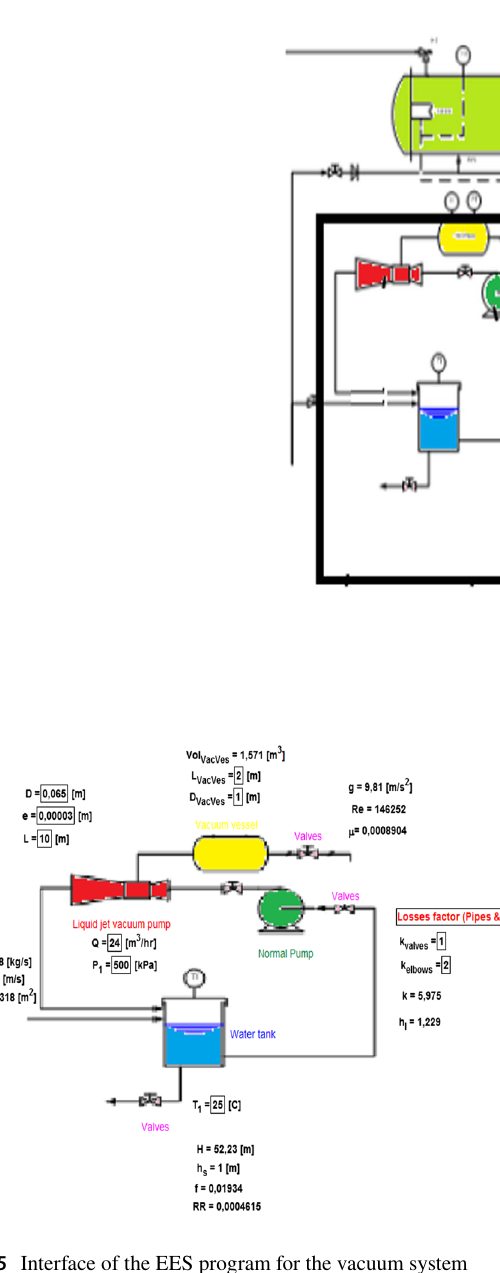
Fig. 14 Pilot desalination facil- ity flow diagram indicating the location of vacuum system